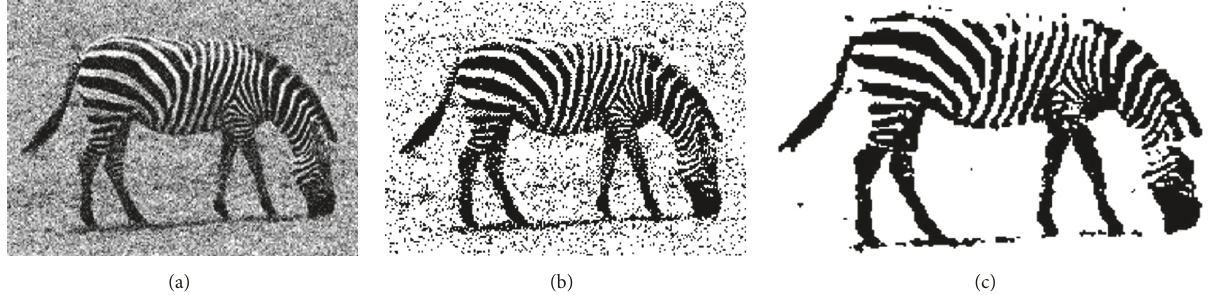
Figure 9: Horse image (mean of Gaussian noise is 0 and variance is 0.02). (a) Original. (b) The results of one-dimensional Otsu method. (c) The results of our algorithm.